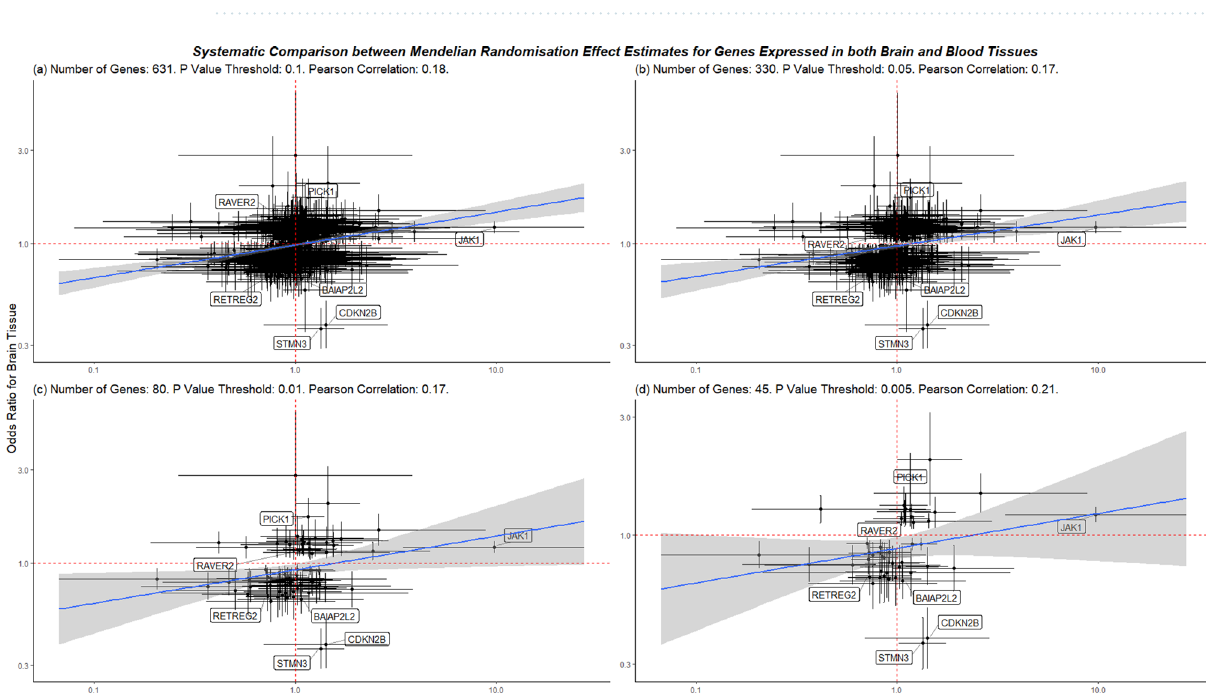
Figure 4. Systematic comparison between the MR results from brain tissues and blood. Any eQTL that appeared in both brain and blood datasets was included in this analysis. We plotted the odds ratios for blood against brain, deciding which results to include based on a P value cut-off: ( a ) P < 0.1, ( b ) P < 0.05, ( c ) P < 0.001 and ( d ) P < 0.005. Labels are provided for genes which had an association that passed at least the suggestive P value threshold (P < 9.49 × 10 –5